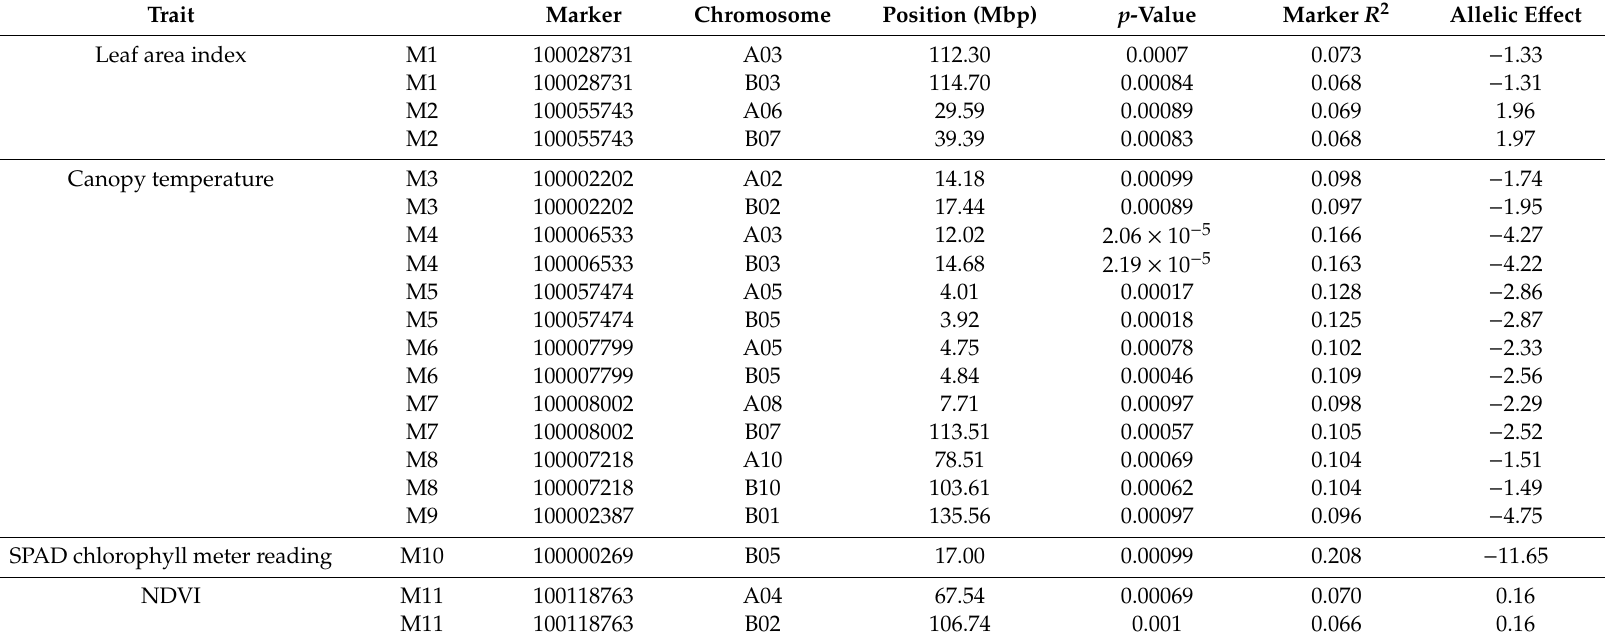
Table 3. Marker-trait associations of four physiological traits of groundnut in the groundnut mini core